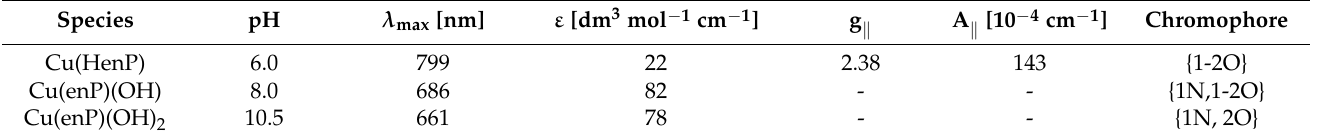
Table 5. Spectral parameters for binary system Cu(II)/enP.